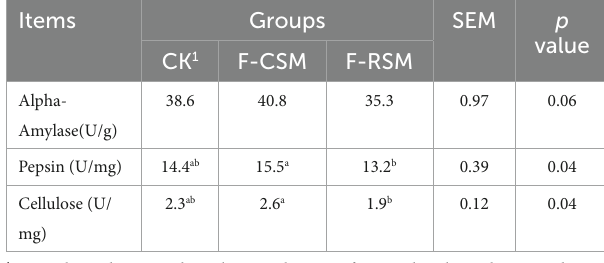
TABLE 4 Effects of the diets on ruminal enzyme activity of Hu